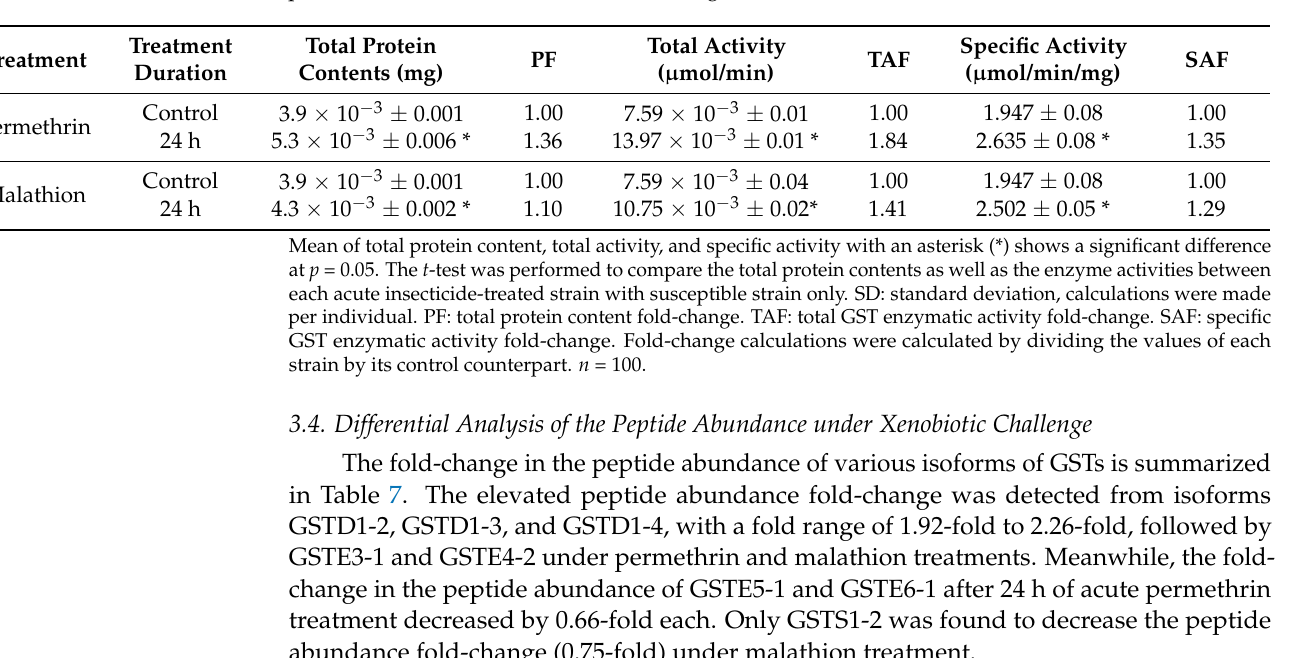
Table 6. Mean of total protein contents (mean ± SD), total GST enzyme activities (mean ± SD), and specific GST enzyme activities (mean ± SD) in Aedes albopictus larvae upon 24 h of acute treatment by permethrin and malathion sub-lethal dosages